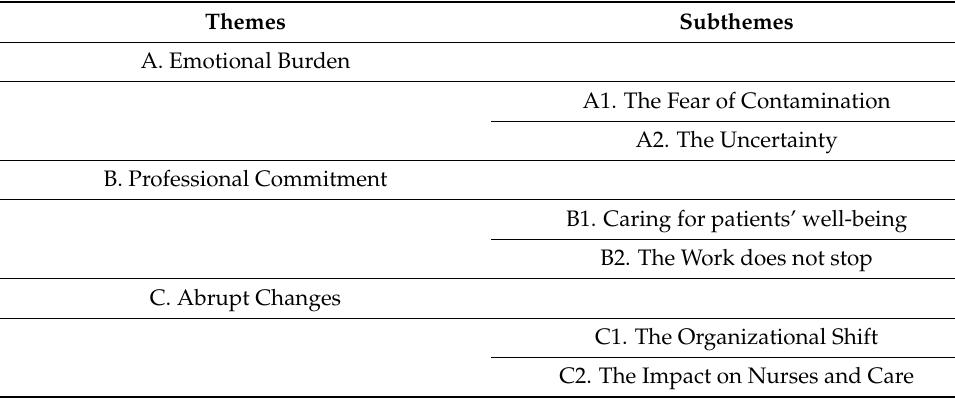
Table 4. Themes and